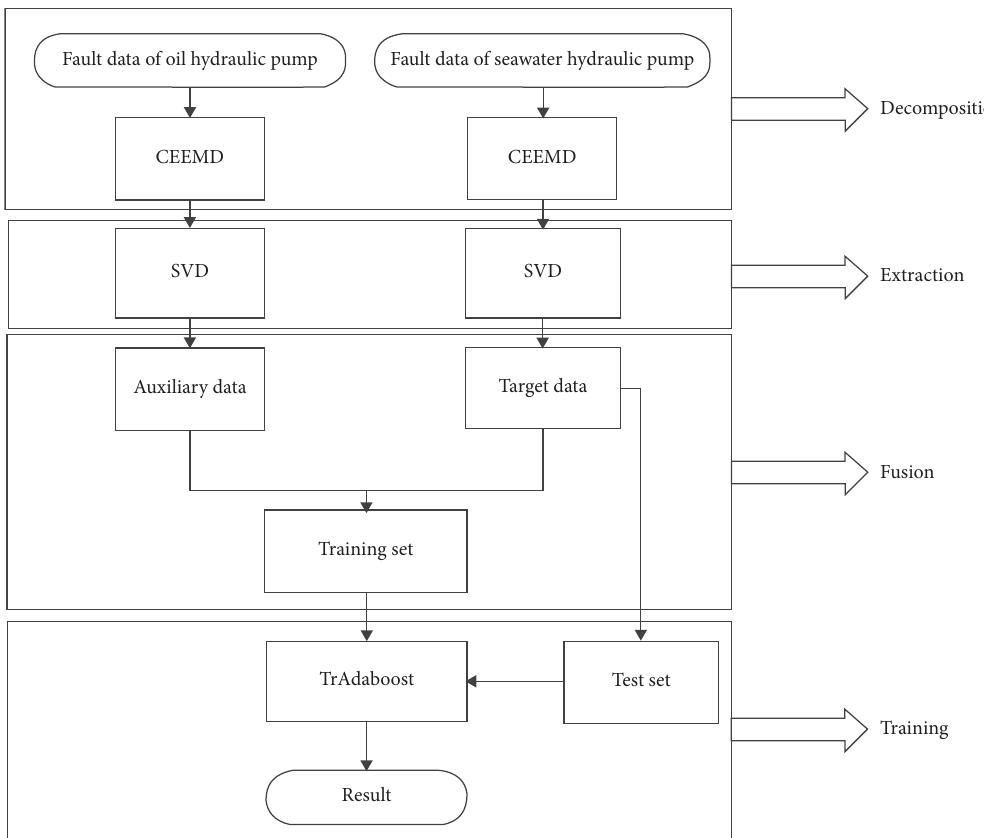
Figure 1: Method